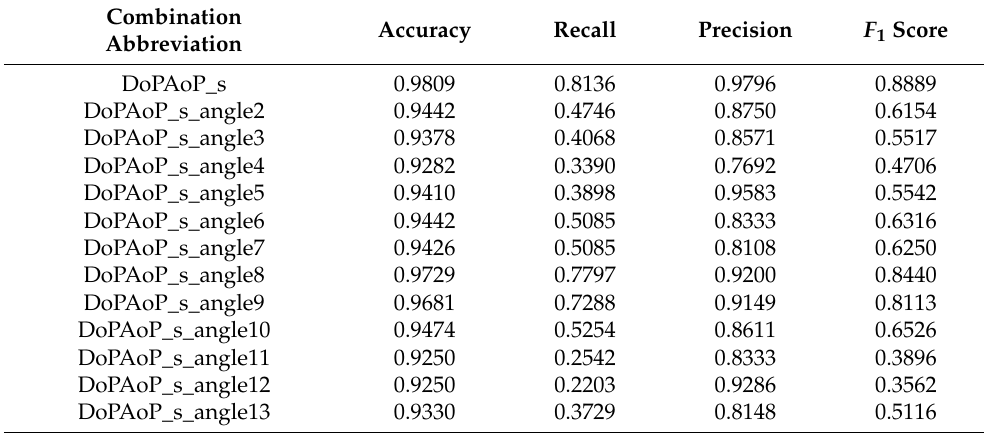
Table 5. Random forest classifier results for different combinations related to